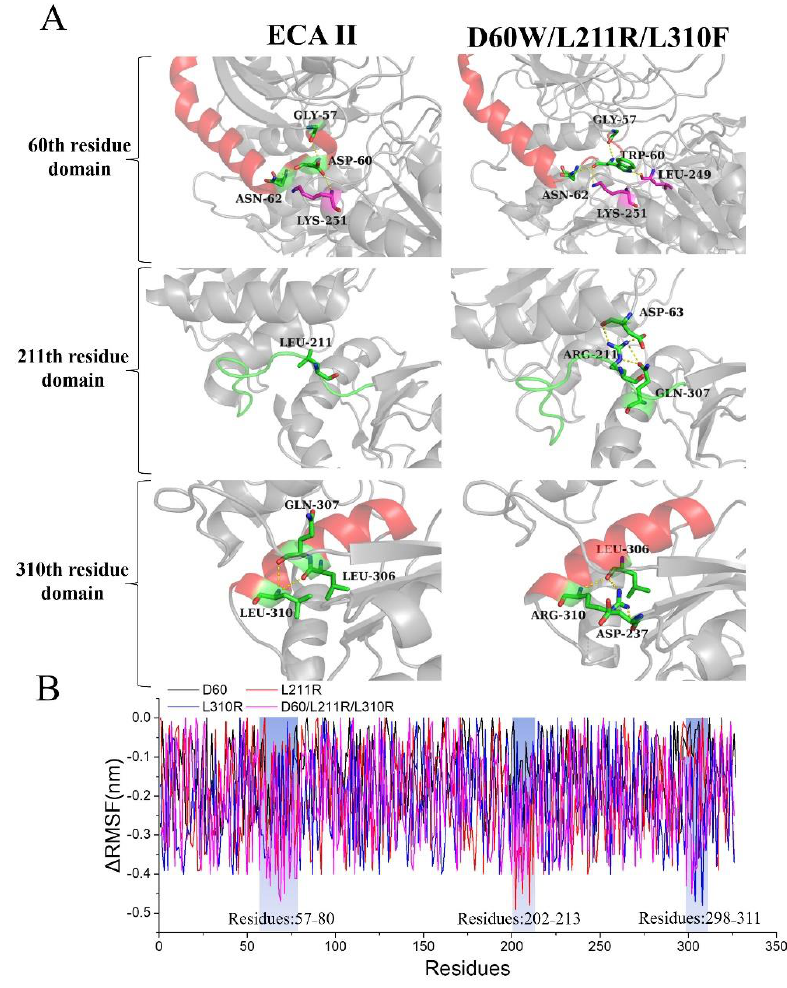
Figure 2. Tertiary structure around ECA stability key residues ( A ) and the changes of RMSF between ECA and its mutants ( B ).